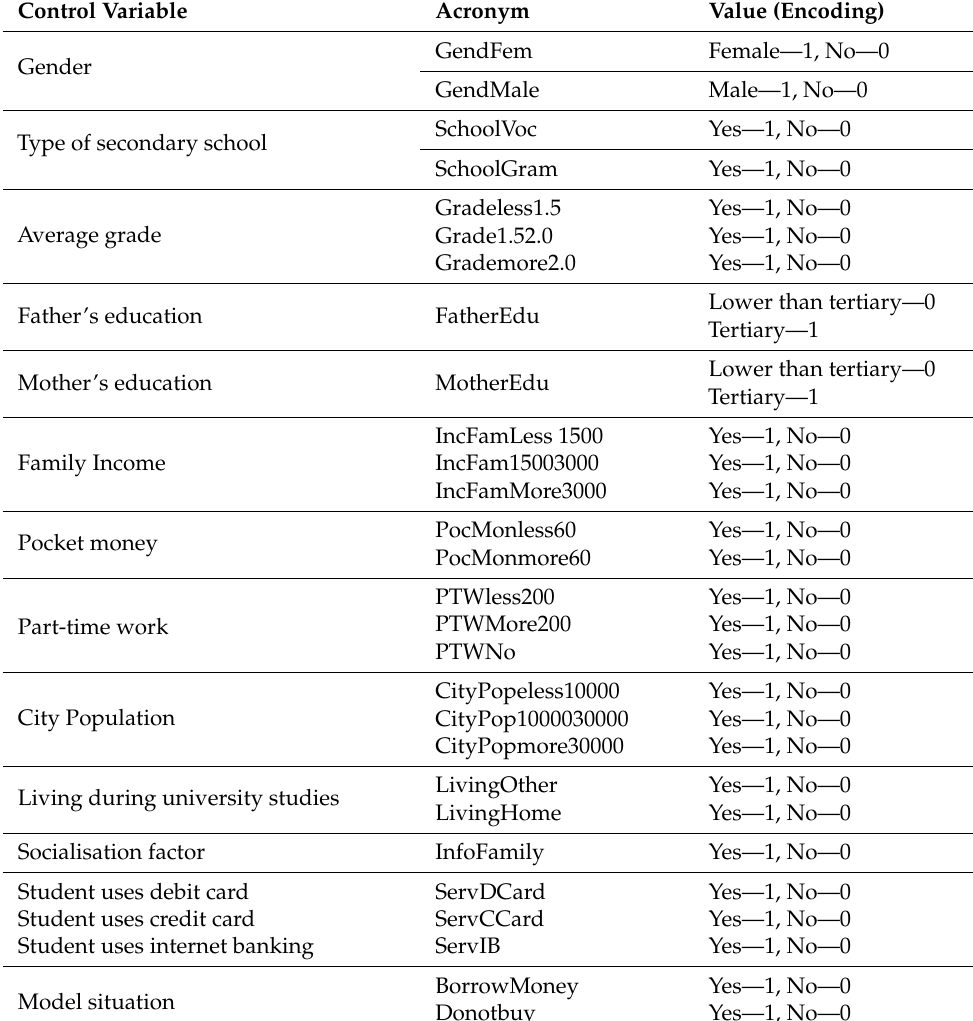
Table 4. Control variables used in the Tobit regression